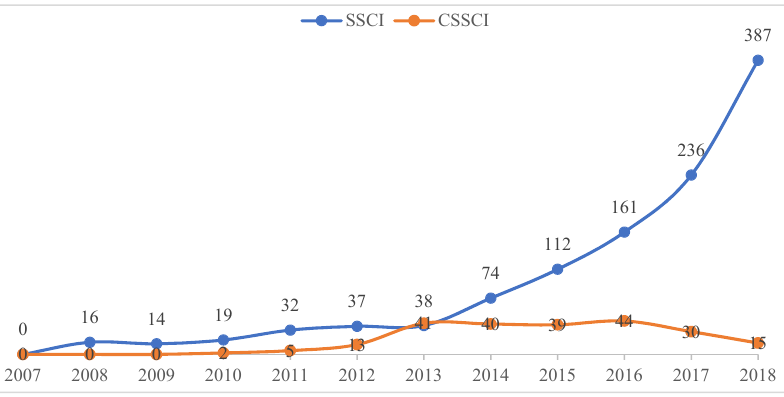
Figure 3. Statistics of SSCI and CSSCI smart city papers (revised from [53]).